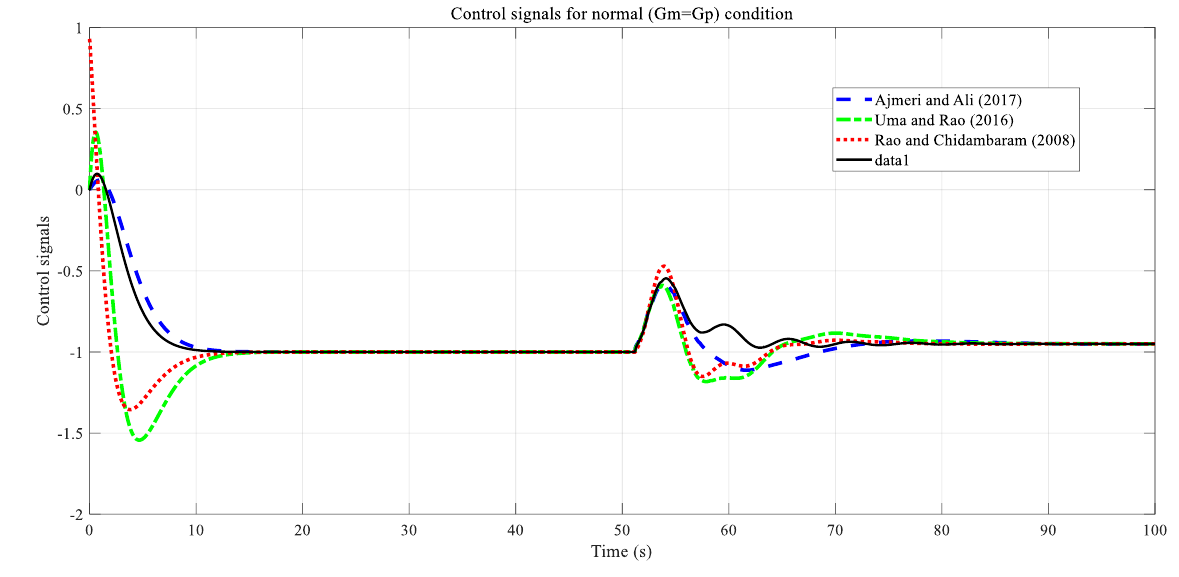
Figure 10. Control signals of the proposed method and other methods for Example 2 [15,16,18].